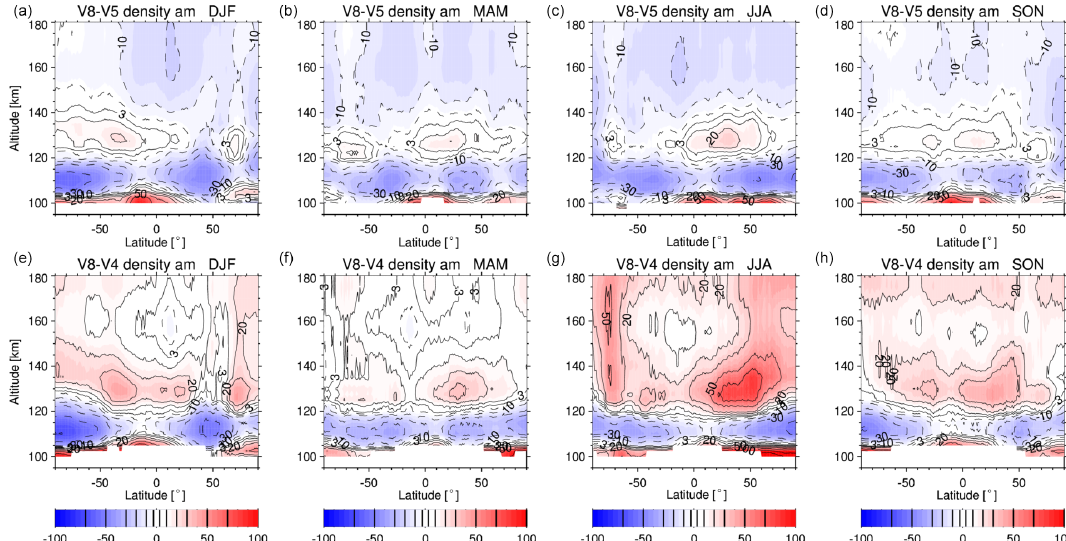
Figure 14. Seasonal composite zonal mean distributions of the relative NO density differences between morning measurements of different UA data versions as a function of latitude and altitude: (a–d) V8R_NOwT_662 versus V5r_NOwT_622 and (e–h) V8r_NOwT_662 versus V4R_NOwT_611. Left to right: DJF, MAM, JJA, SON.